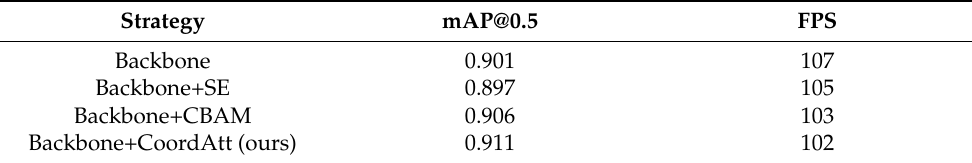
Table 6. Effects of models with different attention mechanisms.